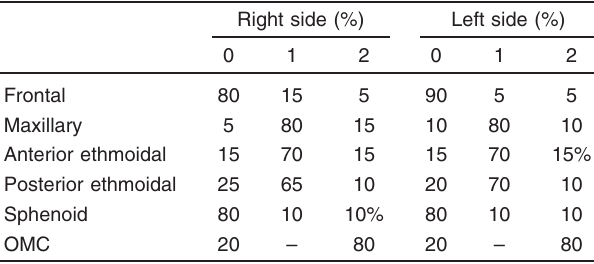
Table 2 Computed tomography sinus score in the patients in group